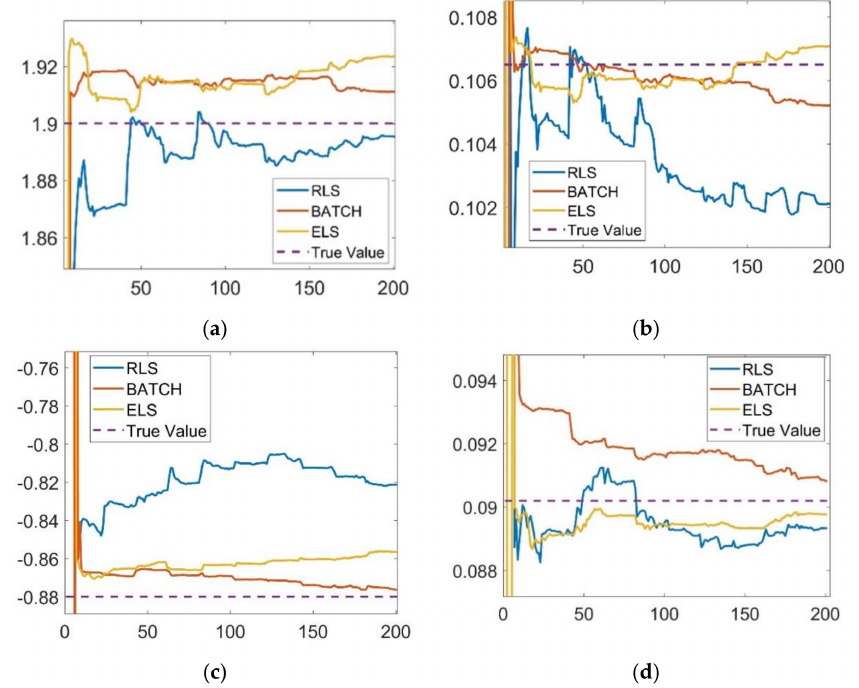
Figure 5. ( a ) Estimation of parameter a 1 on ordinate with time in seconds on the abscissa. ( b ) Estima- tion of parameter b 0 on ordinate with time in seconds on the abscissa. ( c ) Estimation of parameter a 2 on ordinate with time in seconds on the abscissa. ( d ) estimation of parameter b 1 on ordinate with time in seconds on the